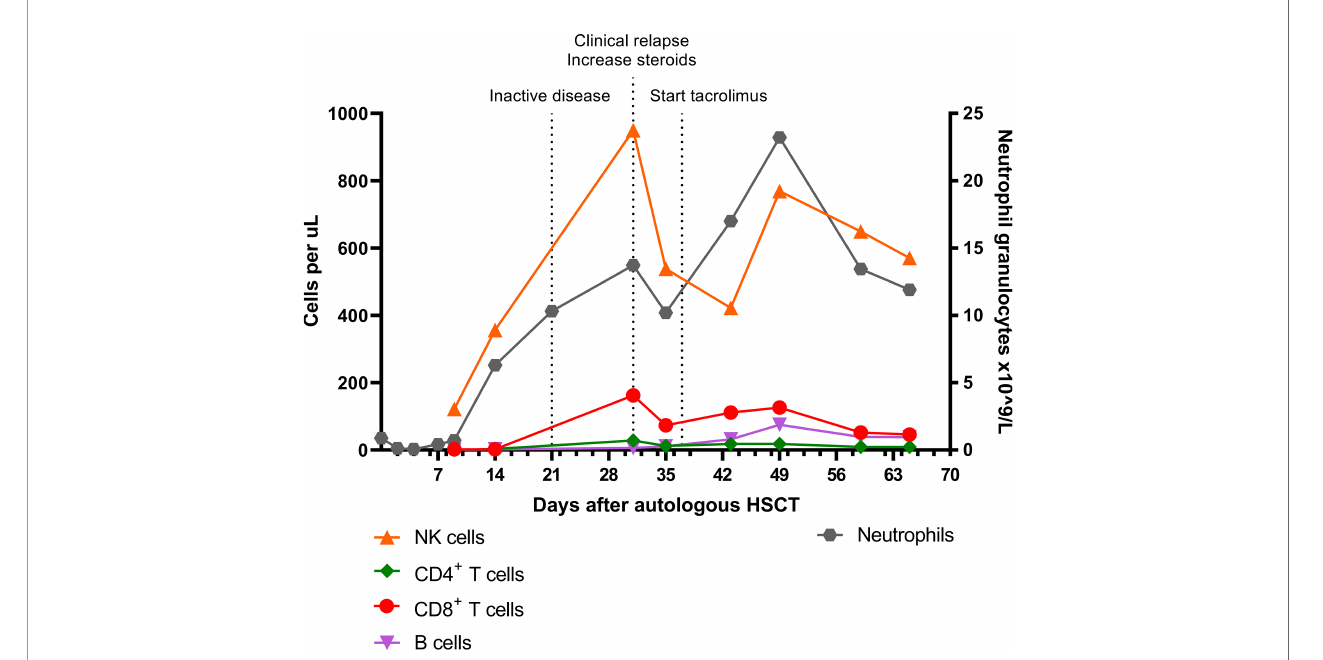
FIGURE 2 | Absolute NK cell, CD4 + T cell, CD8 + T cell, B cell, and neutrophil granulocyte numbers in the early phase after autologous HSCT. Inactive disease status on day 21 was based on a normal F-18-FDG PET scan and absence of symptoms. NK cell, Natural Killer cell; HSCT, hematopoietic stem cell transplantation; PET, positron emission tomography.